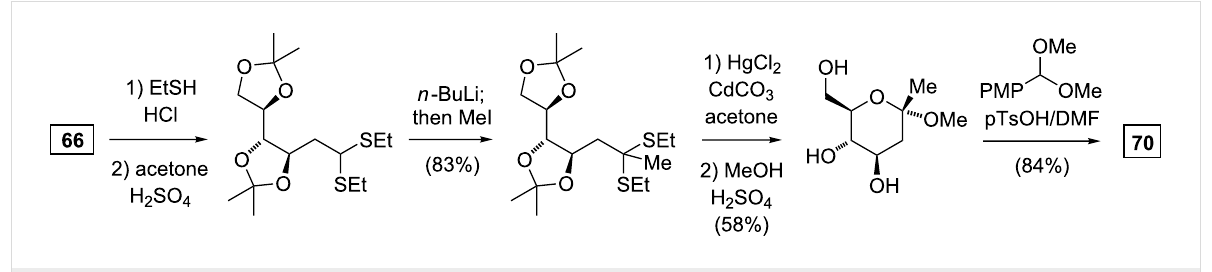
Scheme 11: Kitahara 1st-generation synthesis of the C-1–C-6 fragment of FR901464 ( 1